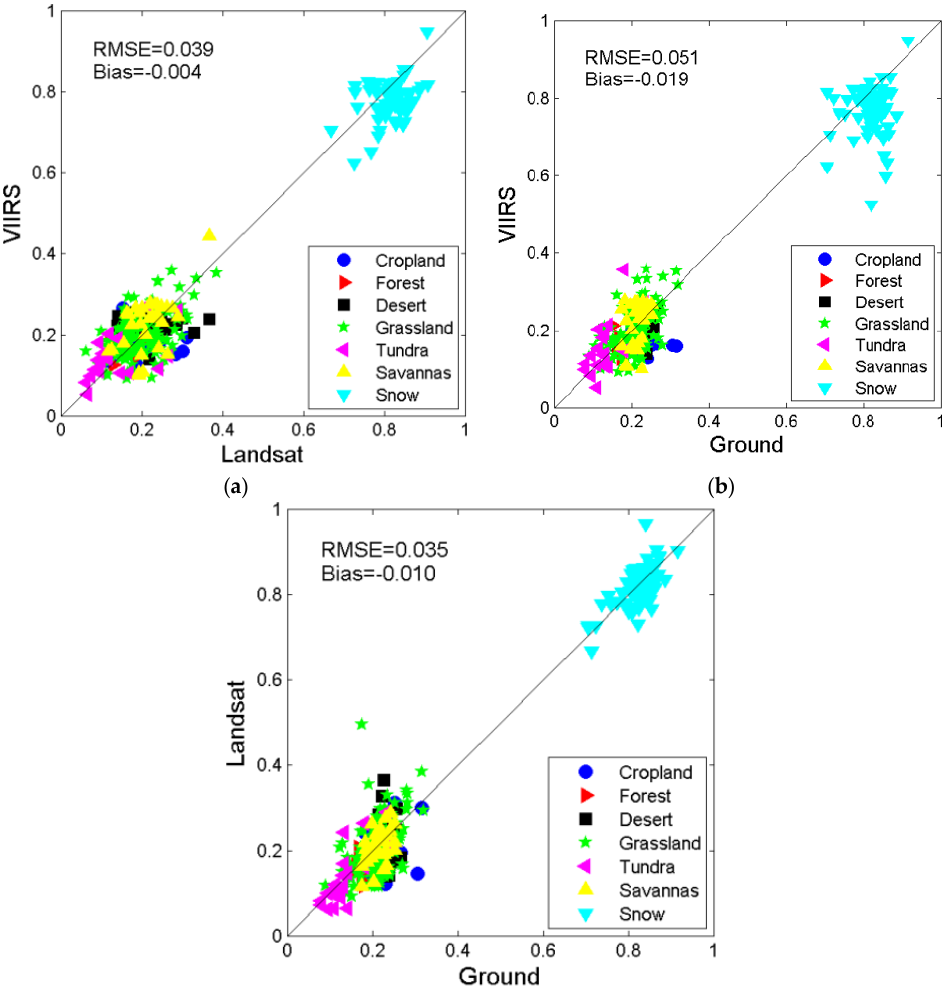
Figure 8. Modified inter-comparison results by excluding snow-covered observations over all non-GCNet sites on the basis of Figure 7. ( a ) VIIRS validated against Landsat; ( b ) VIIRS validated against ground truth; ( c ) Landsat validated against ground truth.